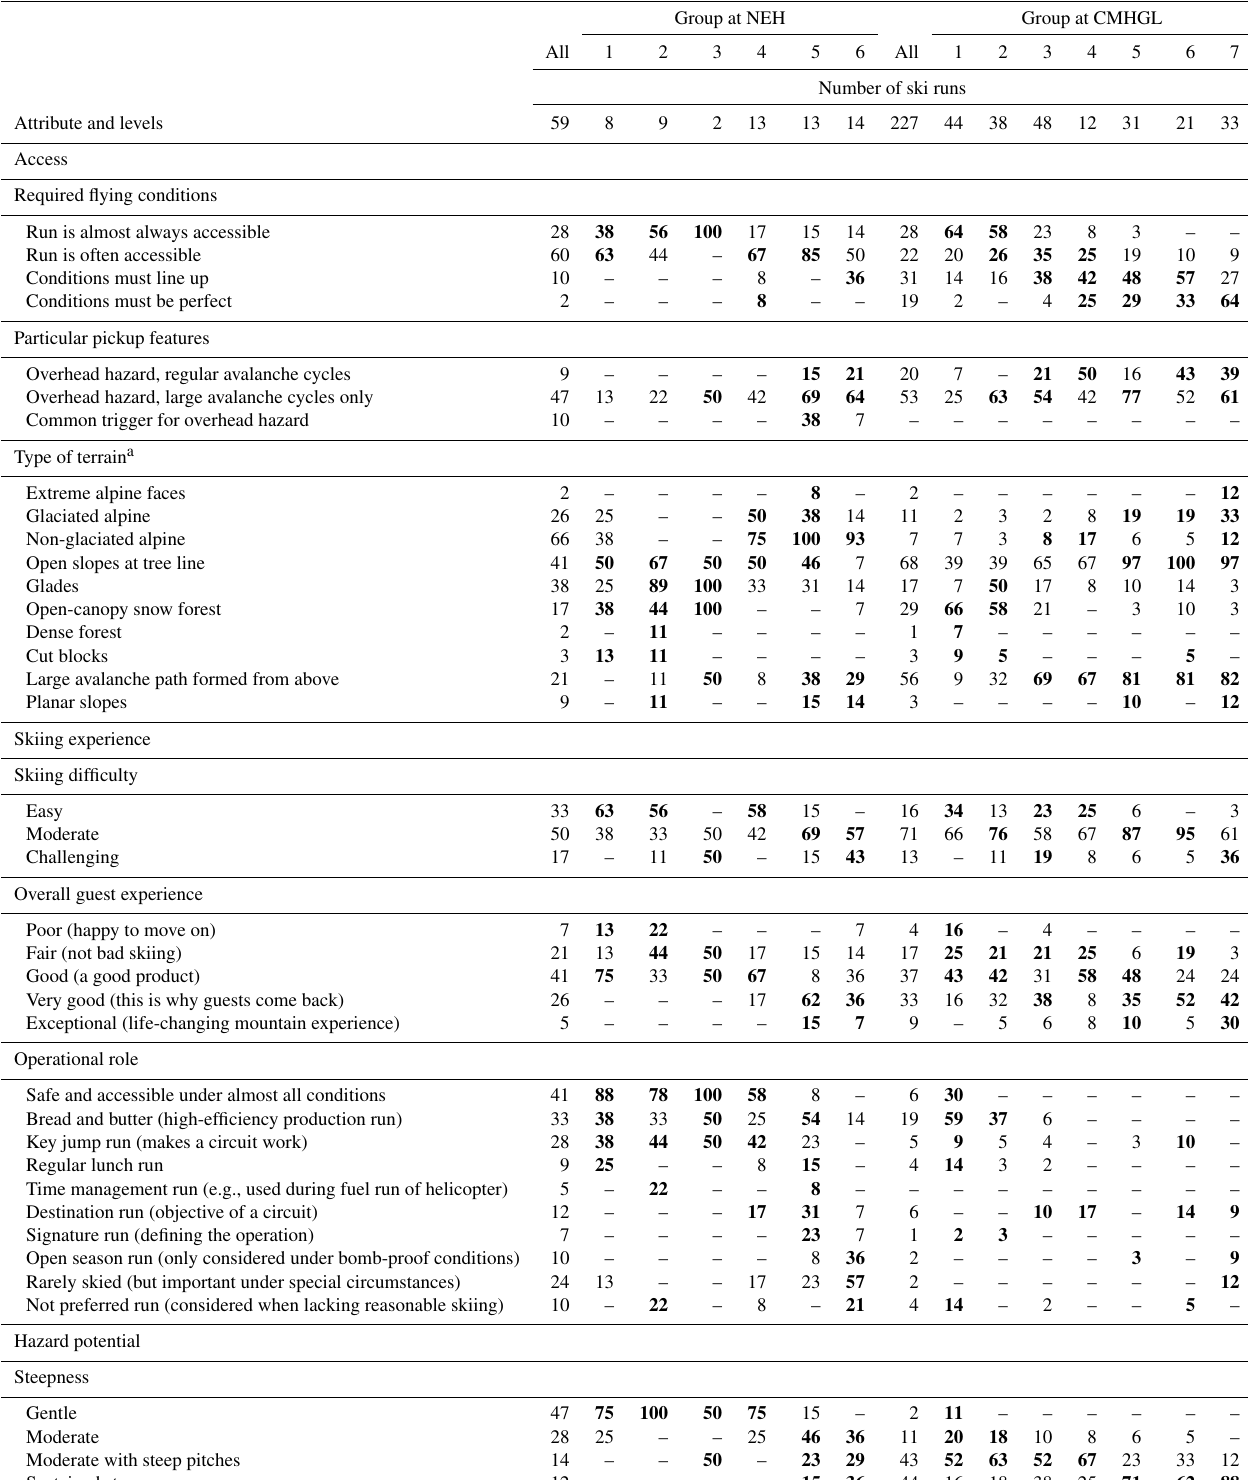
Table 1. Characteristics of the identified ski run groups at NEH and CMHGL (percentages that are greater than the basic distribution across all groups at an operation are highlighted in